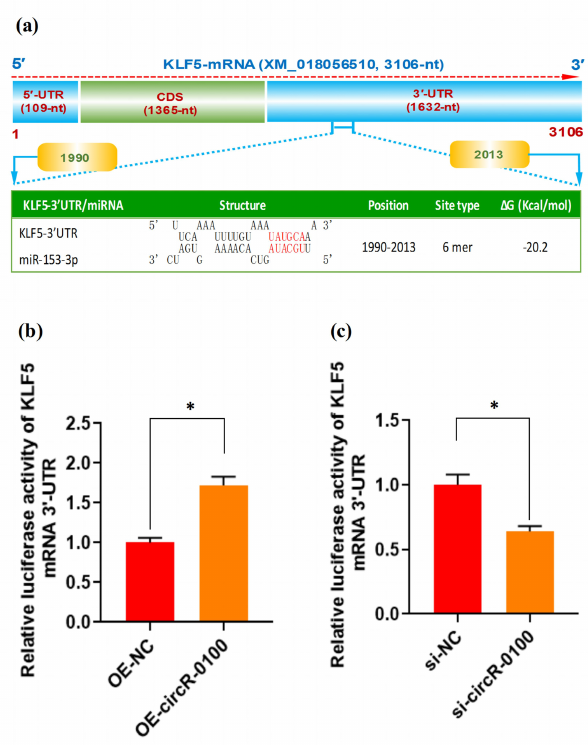
Figure 5. The effect of miR-153-3p on the expression of KLF5 mRNA in SHF-SCs of cashmere goats. (a) An overall diagram of goat KLF mRNA and prediction of potential binding sites of miR-153-3p on its mRNA 3 (cid:48) -UTR region. The nucleotide posi- tions are indicated based on the goat KLF5 mRNA with acces- sion no. XM_018056510 at NCBI (https://www.ncbi.nlm.nih.gov, last access: 20 April 2021). (b) Relative luciferase activities of KLF5 mRNA 3 (cid:48) -UTR in SHF-SCs subjected to treatment with the circRNA-0100 overexpression assay. (c) Relative luciferase activities of KLF5 mRNA 3 (cid:48) -UTR in SHF-SCs subjected to the circRNA-0100 knockdown assay. ∗ indicates a significant differ- ence ( P< 0 .